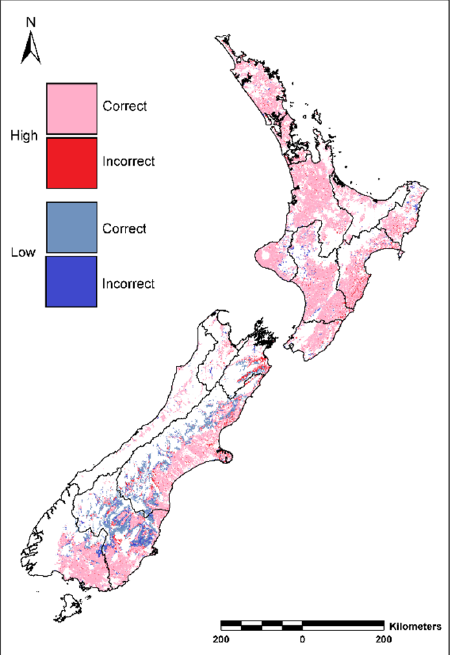
Figure 11. National map of high producing (pink) and low producing (blue) grasslands. Darker shades indicate areas which have been misclassified according to the median NDVI method presented in this paper.